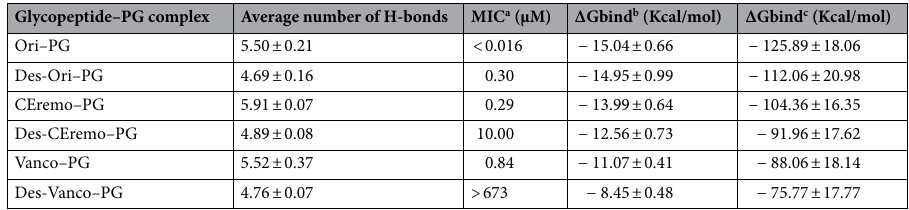
Table 1. An average number of hydrogen bonds, experimental MIC 30 , and free energy of binding for the (desleucyl)glycopeptide–PG complexes. a Experimental minimal inhibitory concentration. b Binding energy from umbrella sampling method. c Binding energy from MM/PBSA